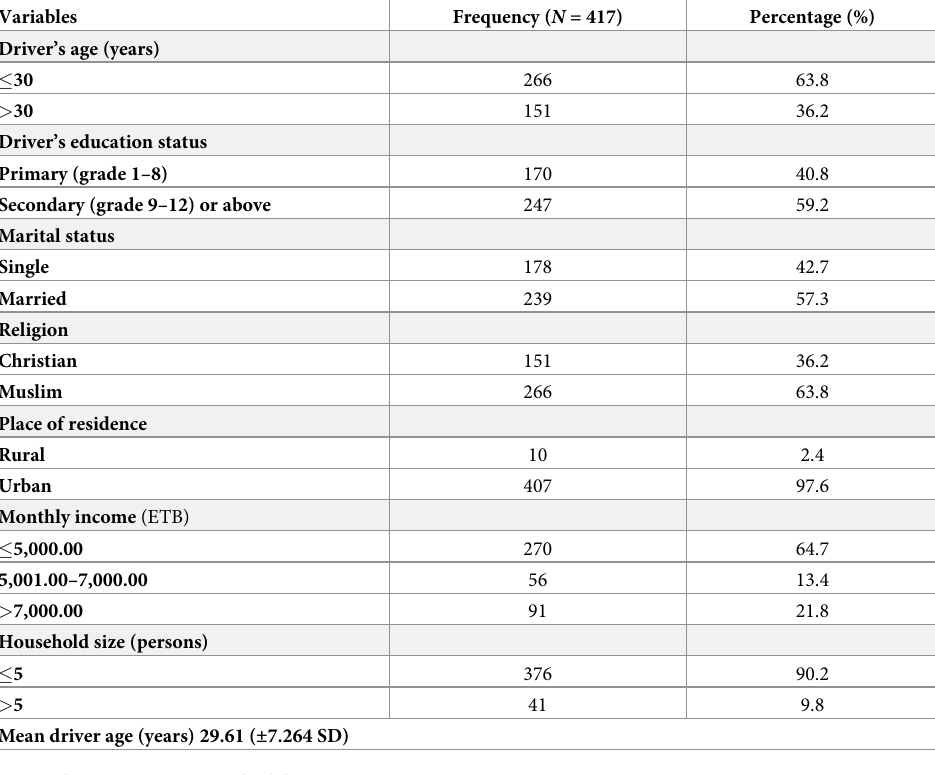
Table 1. Socio-demographic and economic factors among taxi drivers in Dessie City and Kombolcha Town, Ethio- pia, July to August